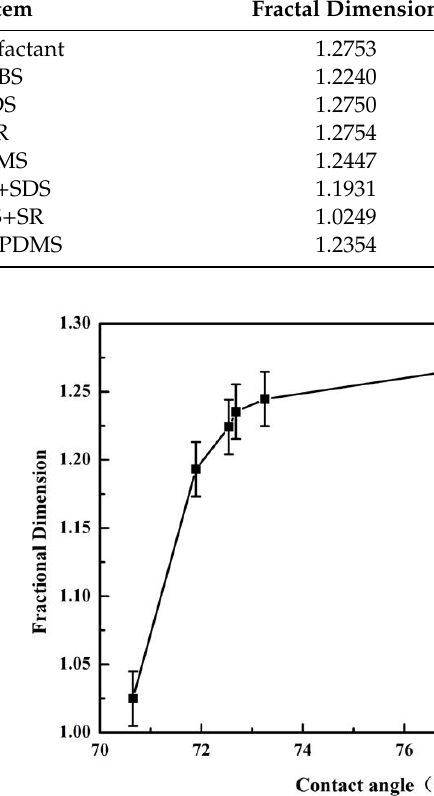
ff ect of contact angle on fractal Figure 5. Effect of contact angle on fractal dimension. Figure 5. E